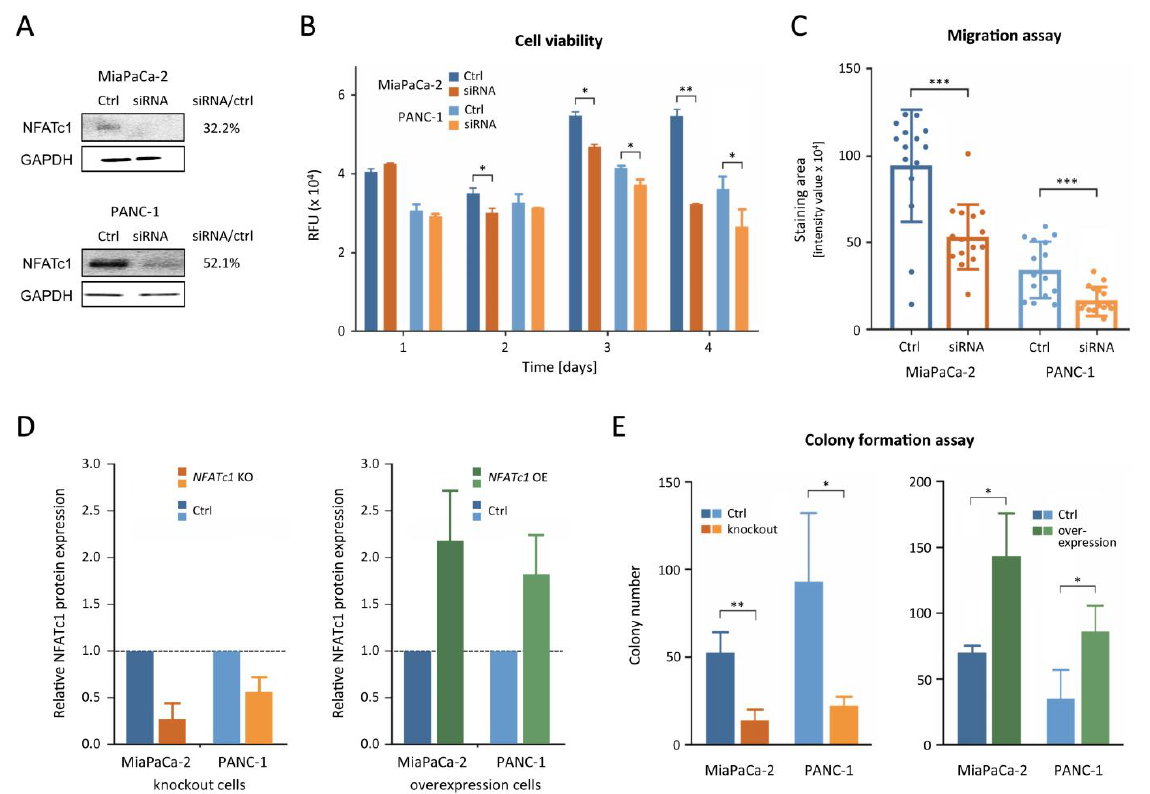
Figure 3. Functional analysis of NFATc1. ( A ) Typical Western blot of NFATc1 protein levels in cell lines PANC-1 and MiaPaCa-2 upon gene knockdown (siRNA) in comparison to controls with constructs of scrambled sequence; the normalized ratios are given. ( B ) Viability of NFATc1 -knockdown (siRNA) or control cells over a period of four days. ( C ) For the same cells, the migration ability was determined after two days. ( D ) Normalized signal intensities of protein NFATC1 on Western blots from cells with CRISPR/Cas-mediated NFATC1 knockout (KO) or overexpression (OE), respectively, in comparison to cells transfected with an sgRNA of unspecific, scrambled sequence (Ctrl; 100% level). ( E ) The colony formation capacity of these cells was analysed. * = p ≤ 0.05; ** = p ≤ 0.01; *** = p ≤ 0.001 . The raw and normalized signal intensity values and images of the original blots of panels A and D are presented in Table S4.